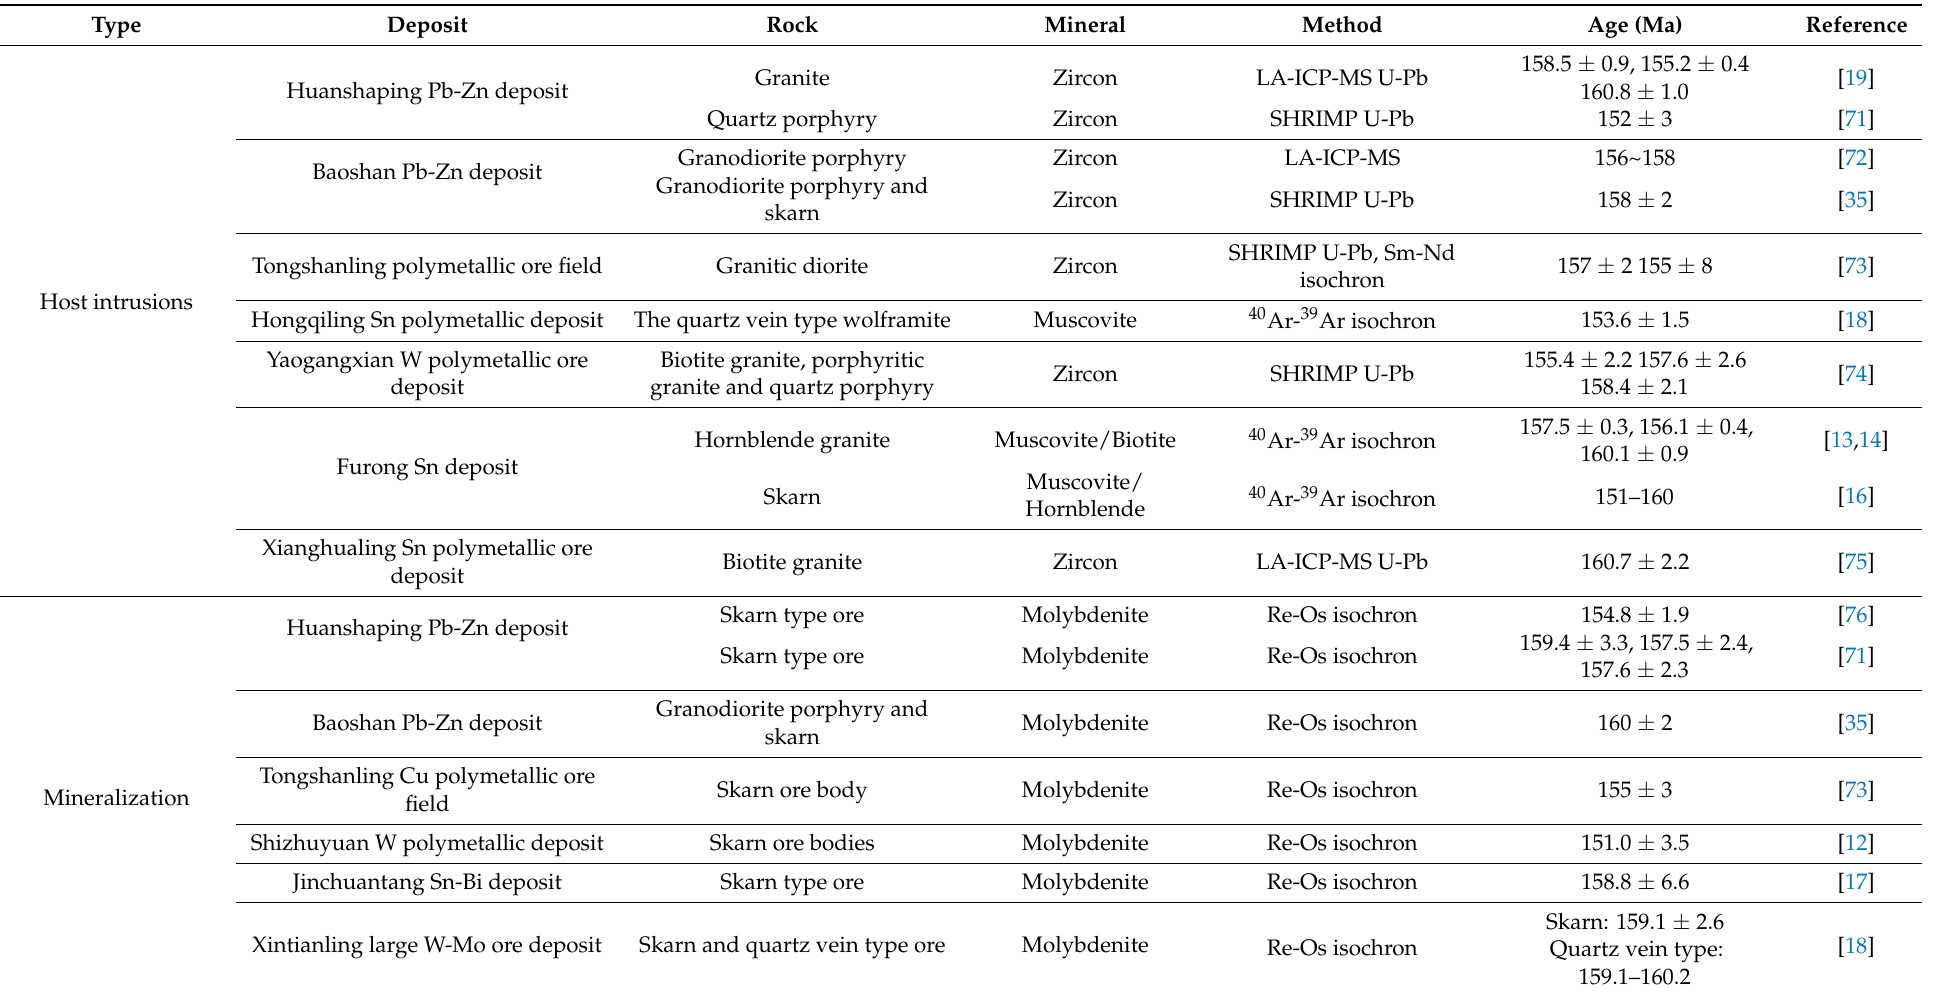
Table 8. Ages of some host representative granoitoids and mineralization in the Nanling